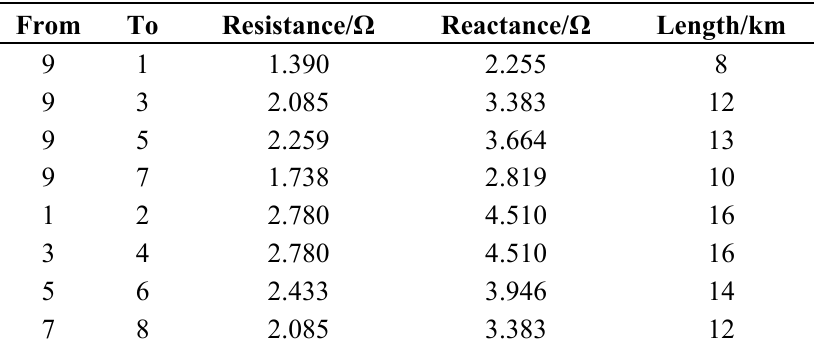
Table 8. The feeder’s